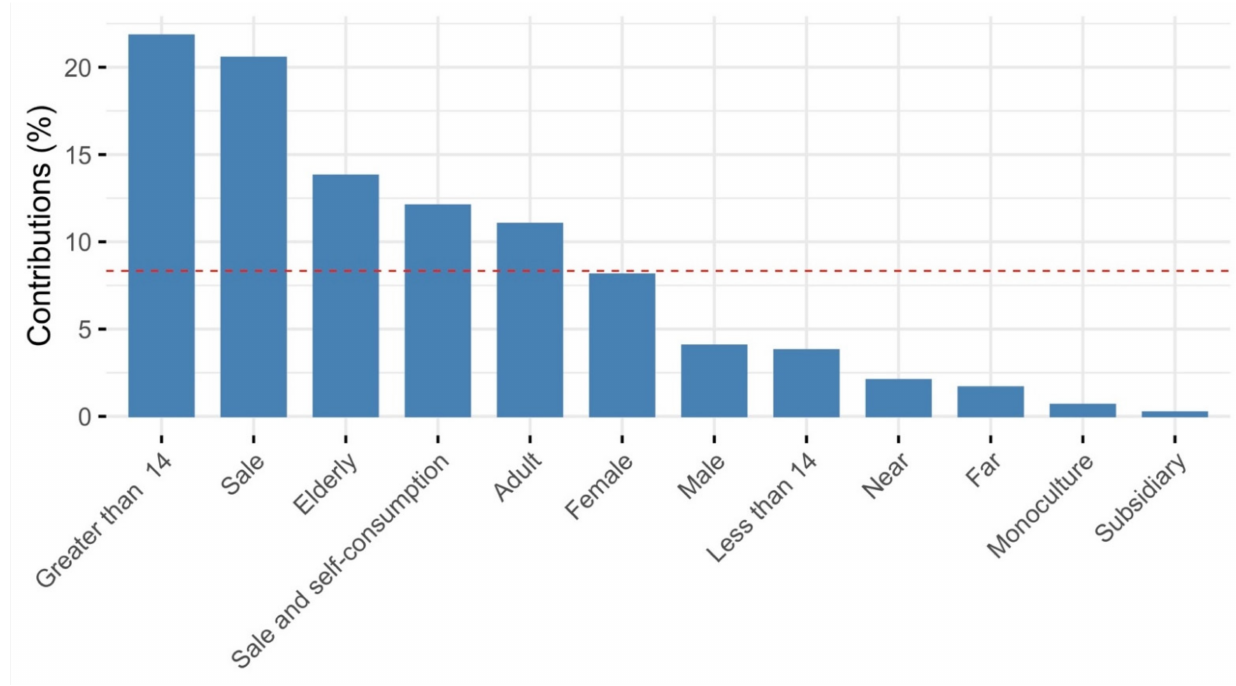
Figure A1. ACM’s dimensions and percentage of explained variances.